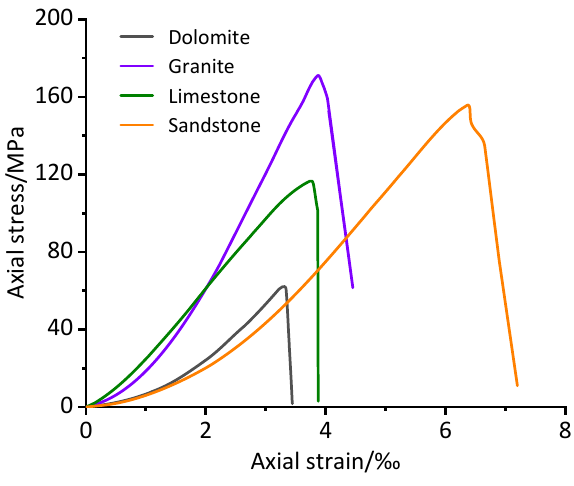
Figure 10. Typical stress ‒ strain curves.